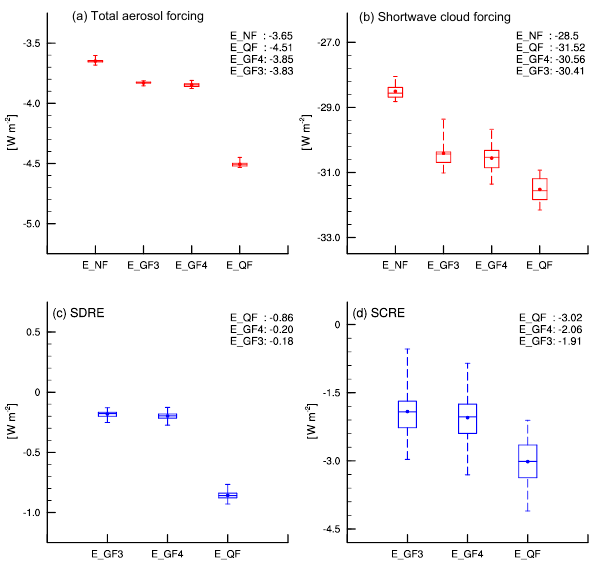
Figure 10. 10-day-average (1–10 April) regional mean (a) total aerosol direct forcing, (b) total shortwave cloud forcing, (c) SDRE, and (d) SCRE in southern Mexico in group B simulations. Boxes denote the 25th and 75th percentiles. Bars outside the box indicate minimum and maximum. Bar within the box denotes the 50th per- centile. Total aerosol and cloud forcing are sampled from differ- ent ensemble members (10 for each case). Fire aerosol SDRE and SCRE are sampled by calculating the difference between members in simulations E_QF (E_GF3/E_GF4) and E_NF (10 × 10 for each